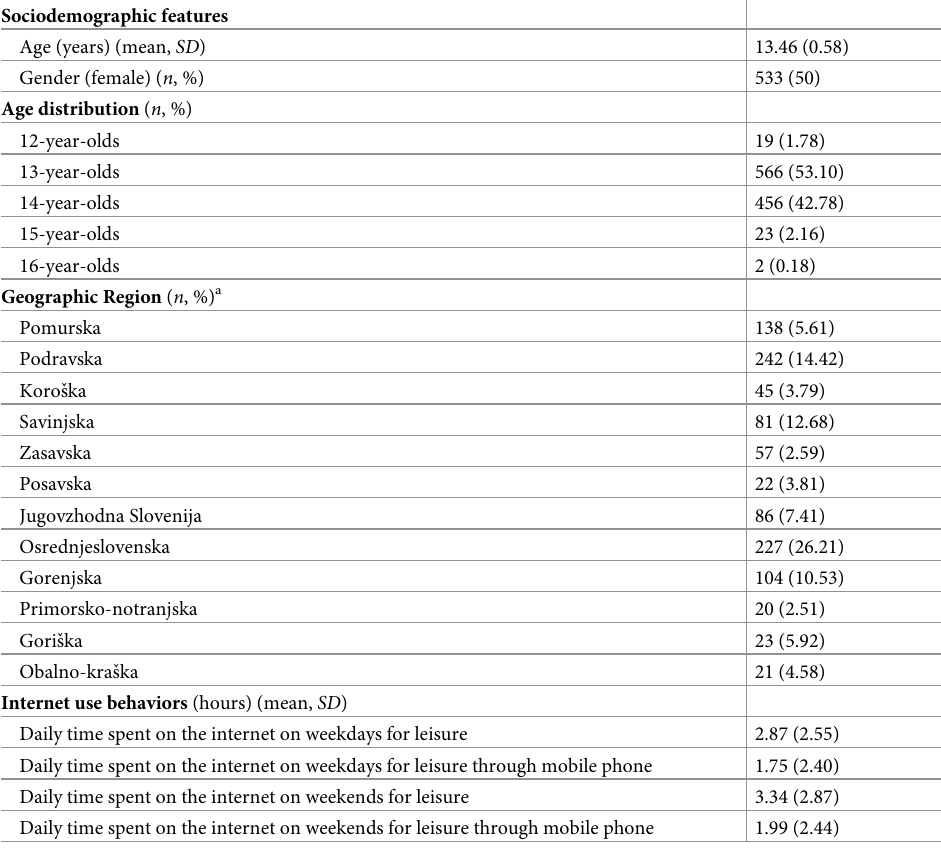
Table 1. Main sociodemographic characteristics of the sample (N =